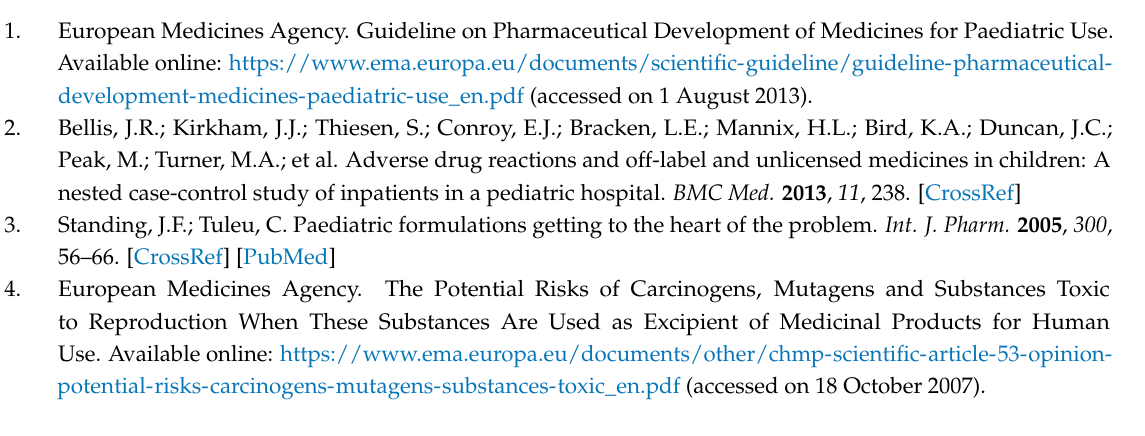
Figure S1: Phase solubility studies of HCT with SBE β CD ( (cid:7) ) and with HP β CD ( (cid:4)